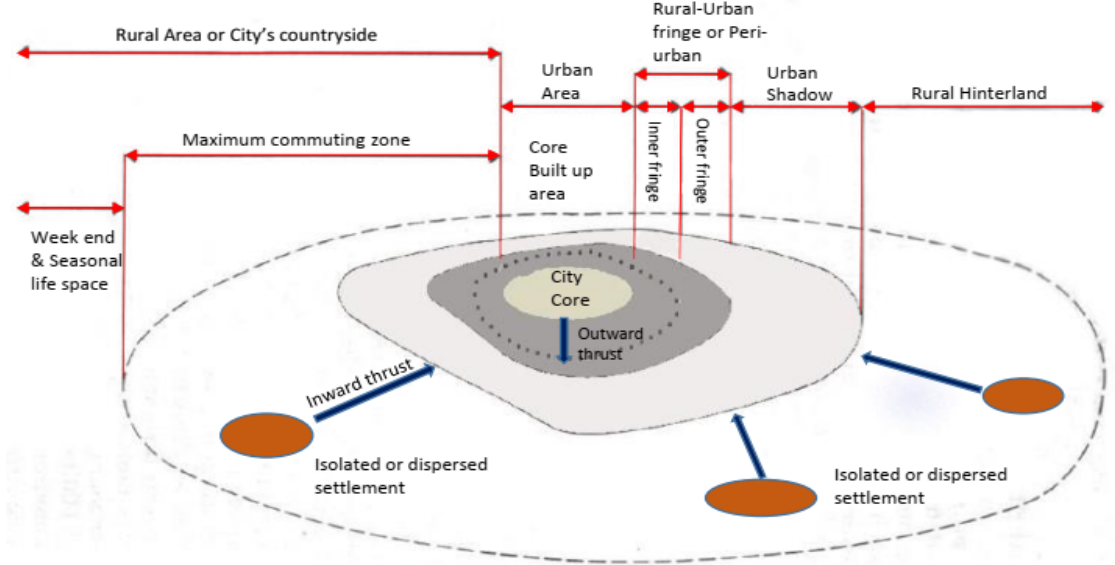
Fig. 1: The rural-urban fringe (Modified from Thou, 2013